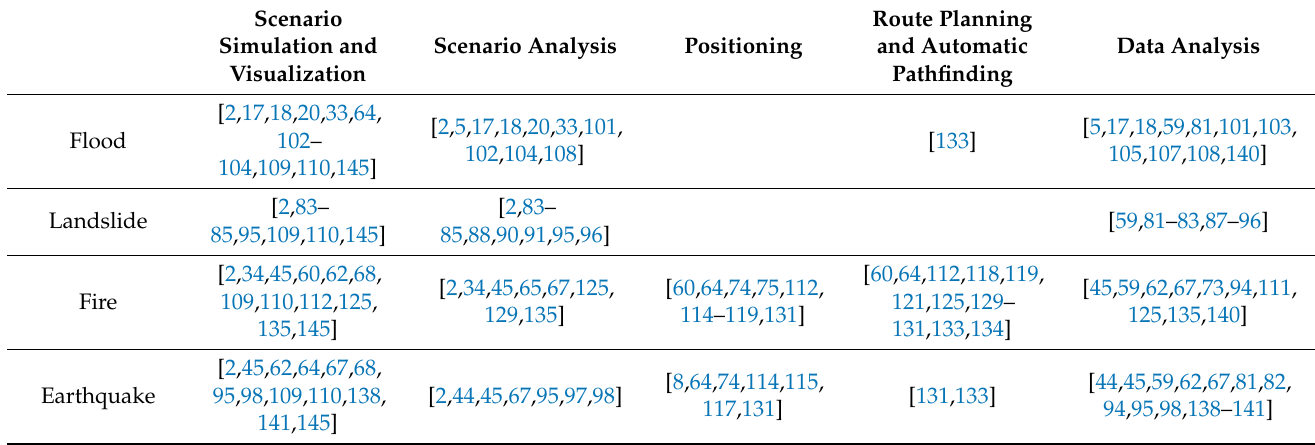
Table 4. The Capabilities of BIM–GIS Integration in Urban Disaster